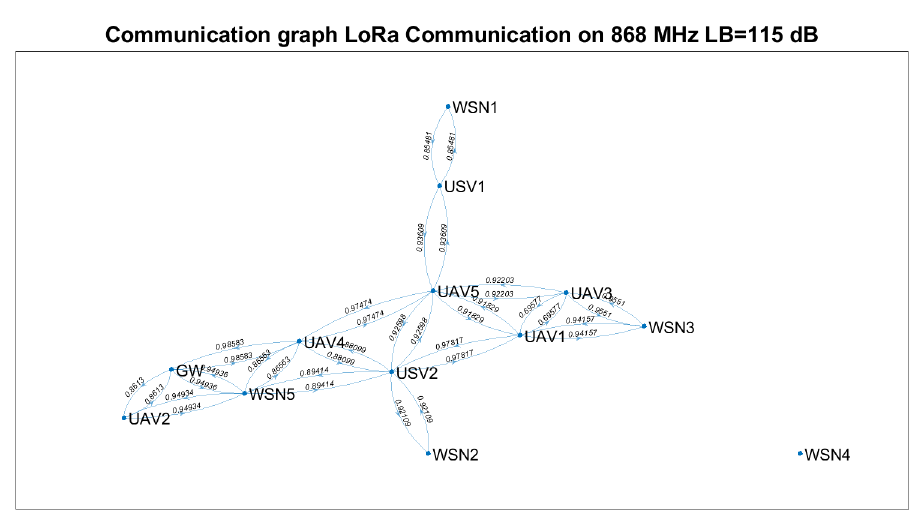
Figure 8. Communication graphs for the technical solutions in [58].